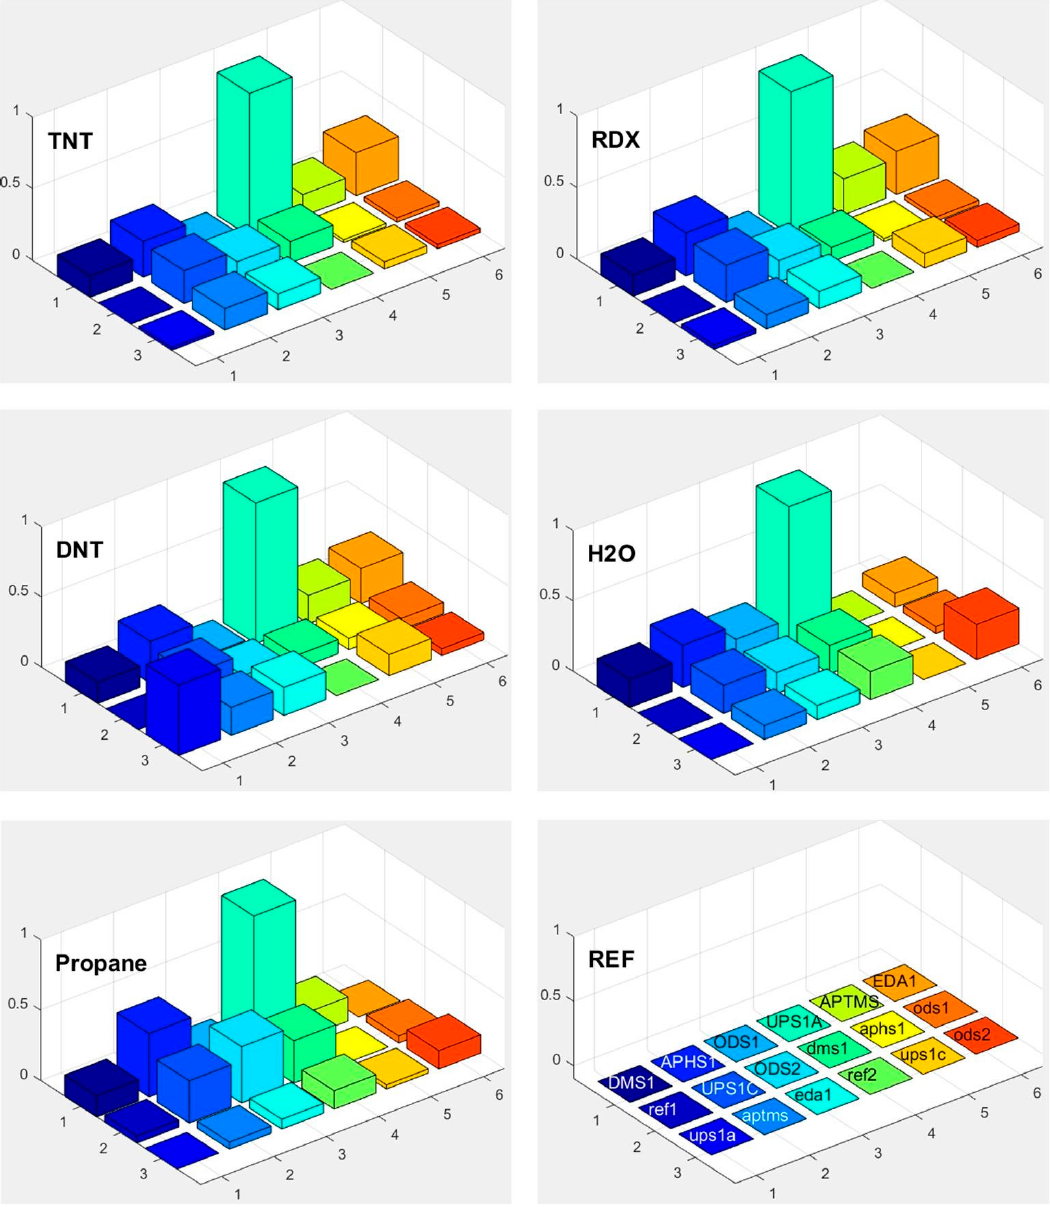
Figure 15. Responses of differently functionalized sensors to vapours of different molecules: TNT, RDX, DNT, H 2 O and propane. The responses were normalized to the response of sensor UPS1A. The positions in the array and different colours of individual pixels shows differently functionalised sensors. The type of the functionalisation layer is printed in the array at the lower right corner (upper case names, for example DMS1, correspond to the active sensor while the lower case names, such as ups1a, correspond to reference sensors, where functionalized layer is removed on both parts of differential sensor).